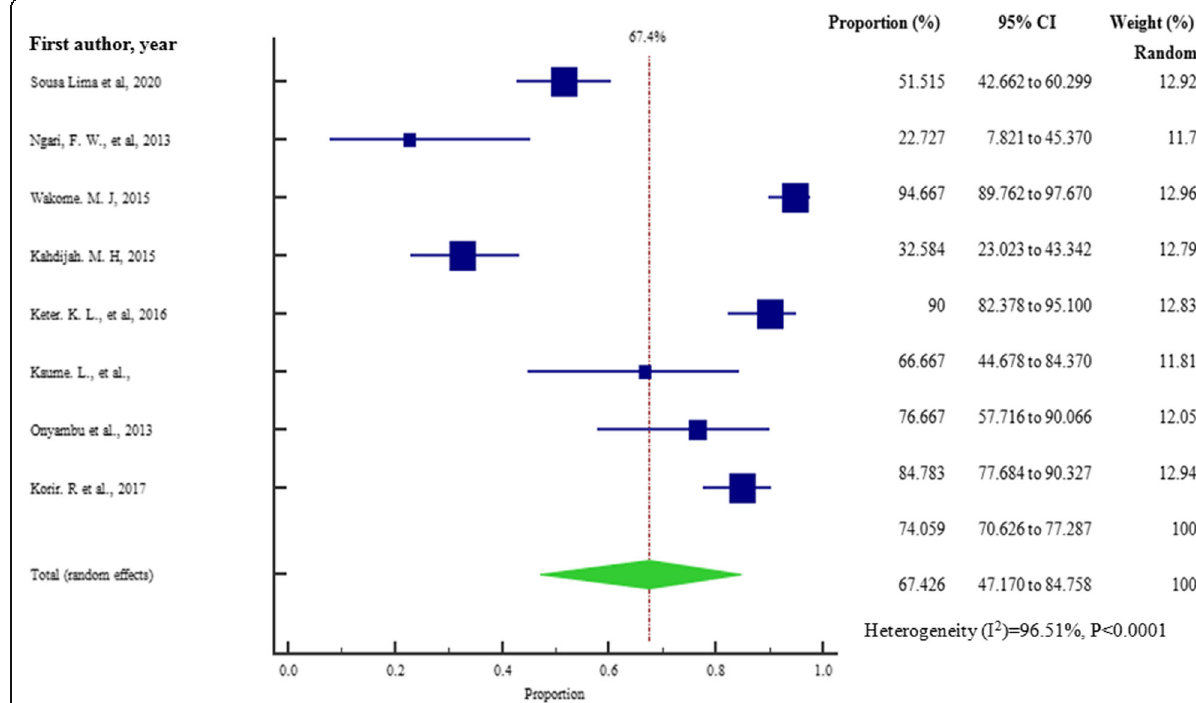
Fig. 5 Pooled prevalence estimates of bacterial contamination in herbal medicines sold in Kenya from the year 2000 to 2020, using random effects model